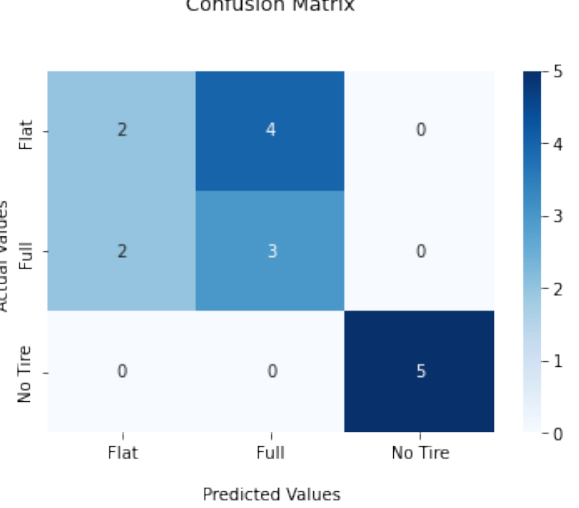
Figure 7. Comparison of prediction accuracies for train and test datasets on the CNN model for the air tire pressure